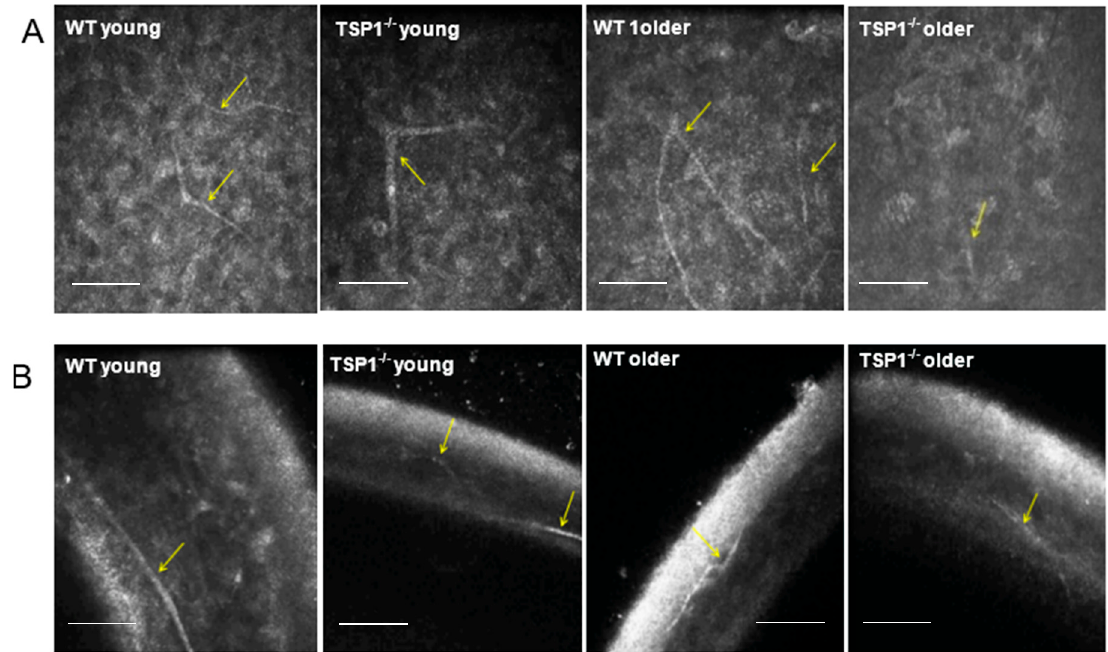
Figure 4. In vivo confocal images from the corneal epithelium of young ( A ) and older ( B ) mice. Branches of corneal nerves emerging from the nerve trunk are indicated by yellow arrows. Scale bars represent 100 μ m . n = 3 for all conditions.